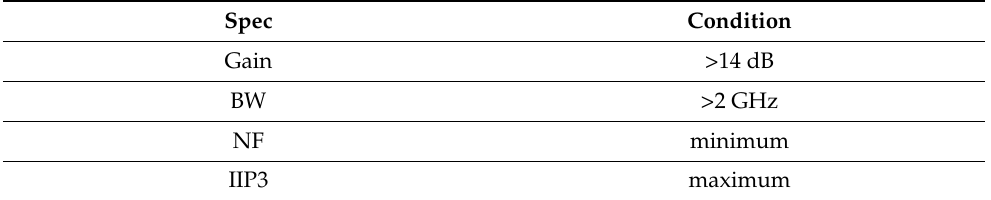
Table 2. Constraints used for the two design examples. The input matching and the noise cancelation gain matching requirements are automatically satisfied.